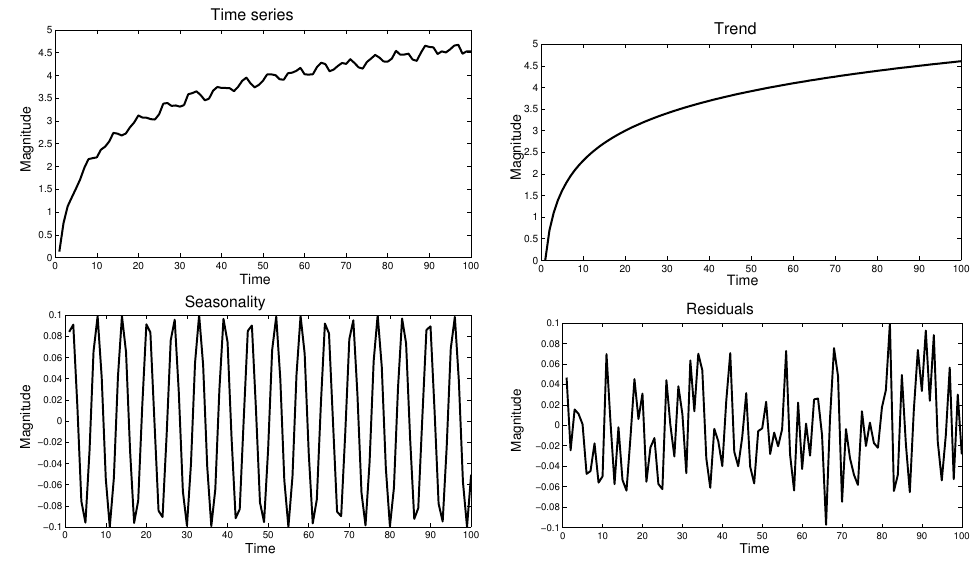
Figure 2. Time series main components